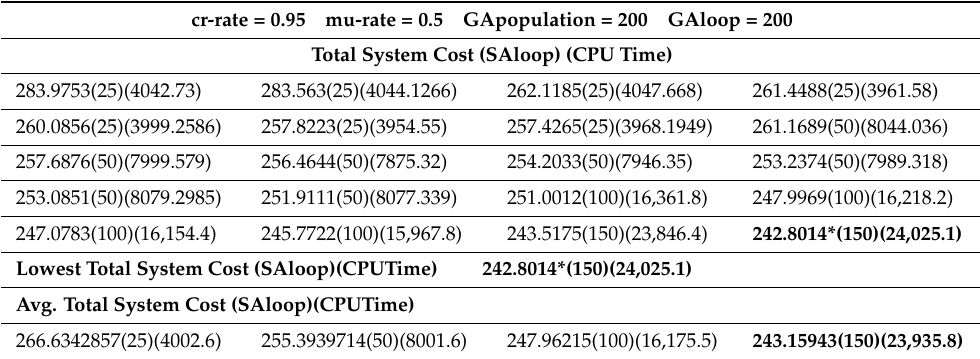
Table 29. The total system costs of 20 simulation runs obtained by SA–MGA for the n -stage q/2 -out- of- q system.